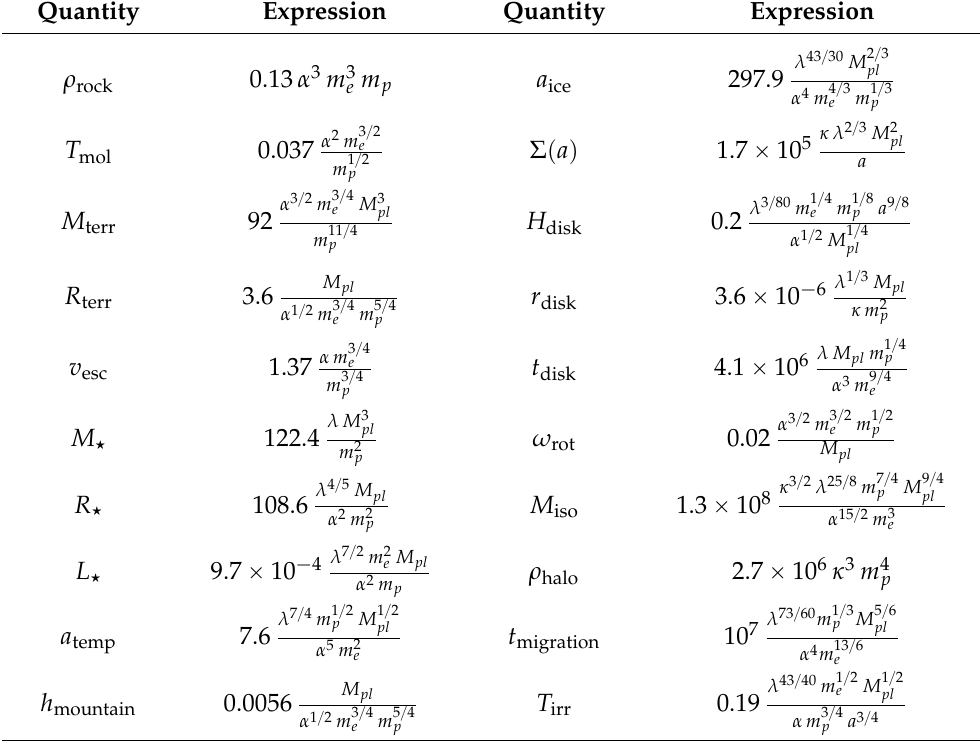
Table A1. List of how various quantities depend on fundamental constants. The quantities in the left column are discussed in [11] except for h mountain , which is discussed in [12]. The quantities in the right column were derived in [7]. Details of the derivations, as well as original sources where applicable, can be found within these references. All prefactors have been chosen to reproduce values observed in our